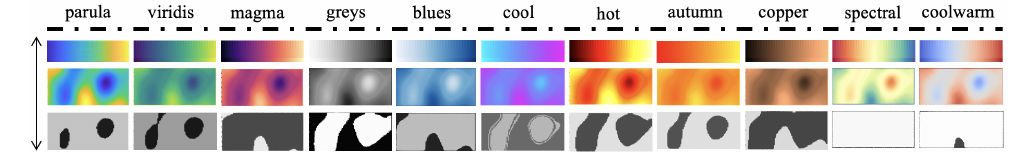
Figure 4. Top-down image processing pipeline (arrow): Each of the 11 colormaps (1st row) is applied to the same MWT image resulting in a new image (2nd row) and yielding corresponding segmented images (3rd row). Due to limited space, we randomly chose one MWT image from our total of eight. The goal of segmentation was to visualize the blue parts in the colormap parula [8].